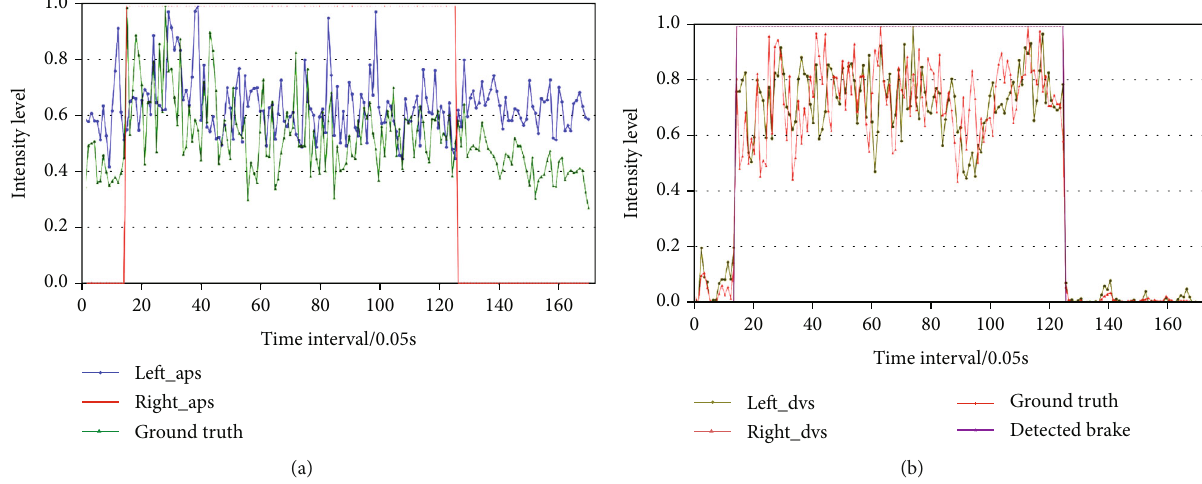
Figure 9: The features extracted from APS frames and DVS events on a testing sequence. In this testing sequence, a preceding vehicle changes its taillight state twice. The fi rst time is the transition from braking-o ff state to braking-on state, and the second time is the transition from braking-on state to braking-o ff state. The Y -axis represents the feature intensity level, which is the relative values compared to the largest feature obtained in the experiment. The actual taillight state of the preceding vehicle is marked in the red line (ground truth), which has no relationship with the intensity values. (a) The features extracted from APS frames. The blue (left_aps) and green (right_aps) lines represent the features levels of the left and right taillights, respectively. (b) The features extracted from DVS events. The olive (left_dvs) and Indian red (right_dvs) lines represent the feature levels of the left and right taillights, respectively. The purple line (detected brake) is the measured signal state by our